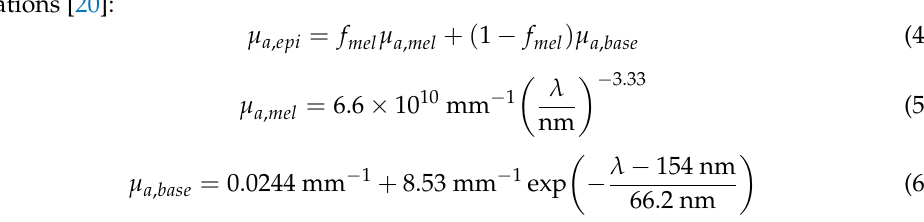
Figure 5. Diagram of the skin model with single port-wine stain (PWS) vessel.